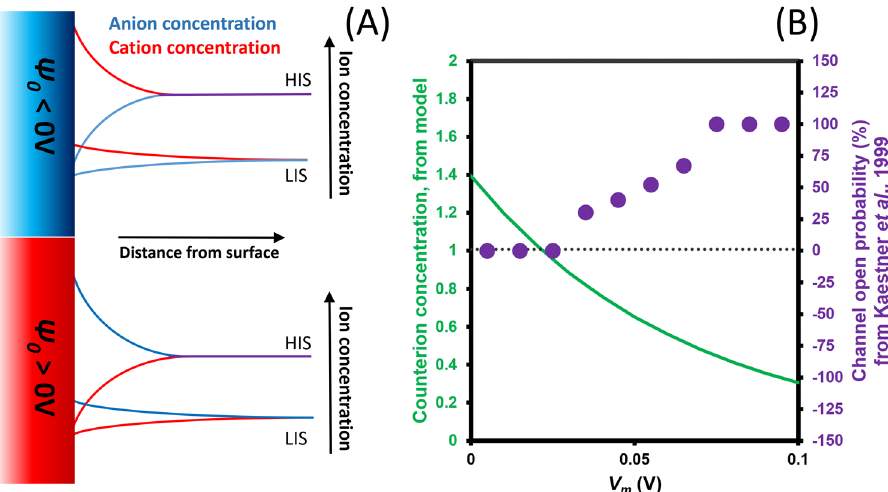
Figure 7. ( A ) A schematic showing ion concentrations in proximity to the cell surface in high ionic strength (HIS) and low ionic strength (LIS) solutions. Where the surface potential of a cell is negative, it will electrostatically attract cations from solution, raising the cation concentration at the surface whilst depleting anions. Where the surface potential is positive, this situation is reversed, with the cation level in HIS solutions reaching similar values to those observed in LIS solutions. ( B ) A comparison of the voltage-gated cation channel behaviour reported by Kaestner et al. 26 , and the cation concentration at the surface relative to the bulk (green line) determined using the Poisson-Boltzmann equation, using ζ determined from Eq.